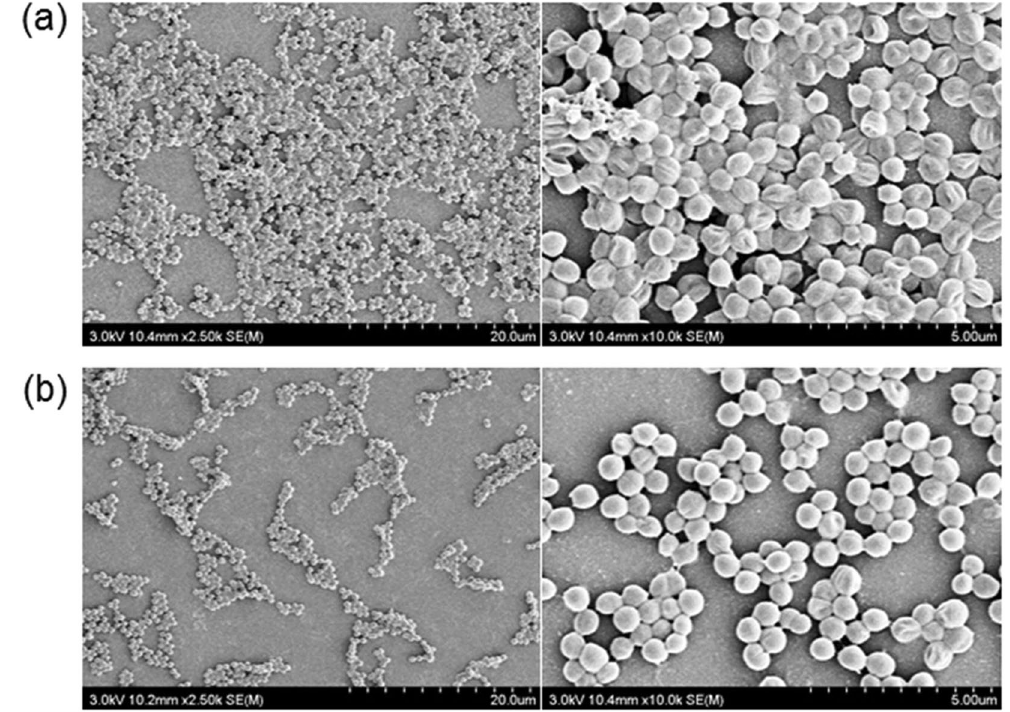
Figure 3. SEM images of S. mutans biofilms after the treatment ( a ) with DW and ( b ) with a solution containing 5.6 mM betaine and 2.8 mM erythritol.